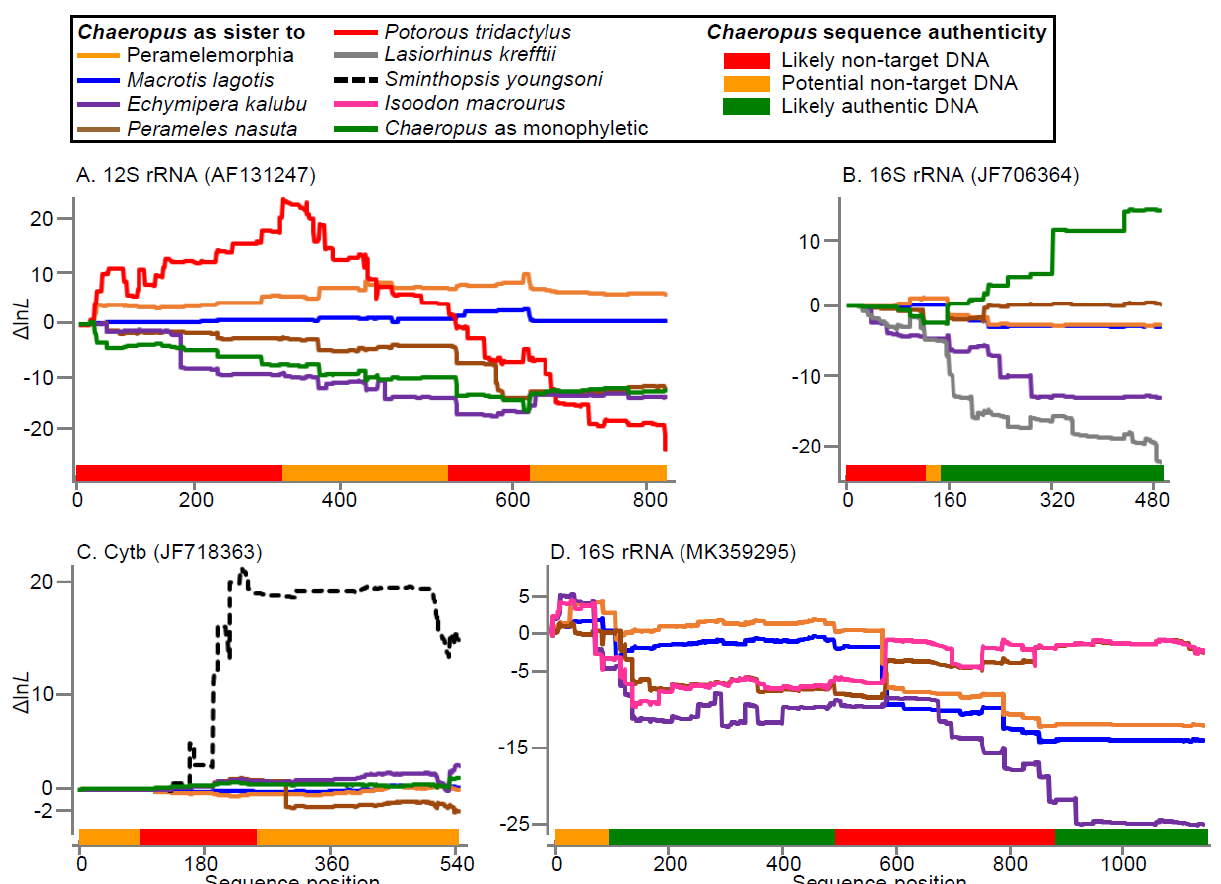
Figure 3. Cumulative ln L differences along gene sequences, for alternative sister group relationships for the published Chaeropus yirratji sequences, ( A ) 12S rRNA (AF131247), ( B ) 16S rRNA (JF706364), ( C ) Cytb (JF718363) and the published Chaeropus ecaudatus sequence, ( D ) 16S rRNA (MK359295 and MK359296 are identical). In each case, the null (zero Δln L ) is for the focal Chaeropus sequence as sister to Peramelidae. Inferences of the authenticity of these sequences are indicated above the x-axes, as likely non-target DNA (red), potential non-target DNA (orange) or likely authentic DNA (green), based primarily on sliding window BLAST and MP bootstrap with densely sampled marsupial alignments (see Tables S3 and S4).